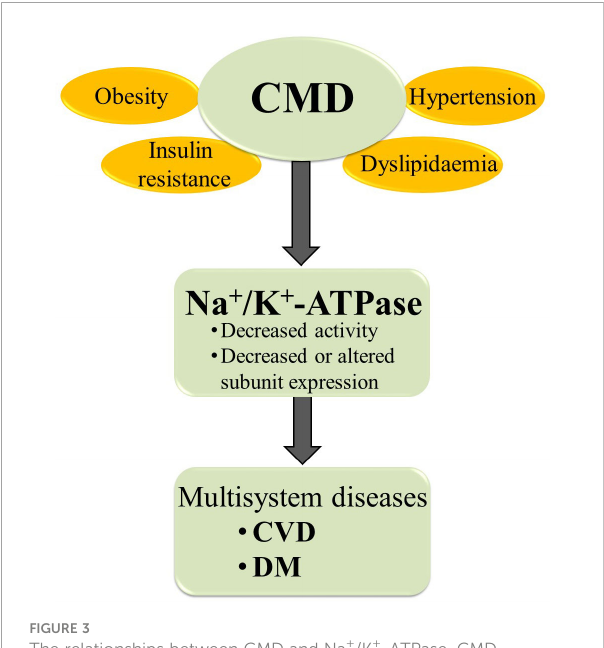
FIGURE 3 The relationships between CMD and Na + /K + -ATPase. CMD, cardiometabolic diseases; CVD, cardiovascular diseases; DM, diabetes